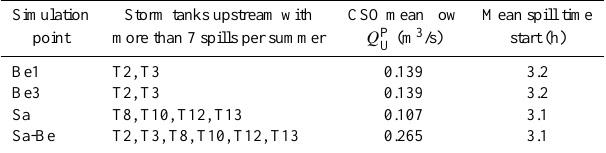
Table 6. Coupled results for a non-exceedance probability P